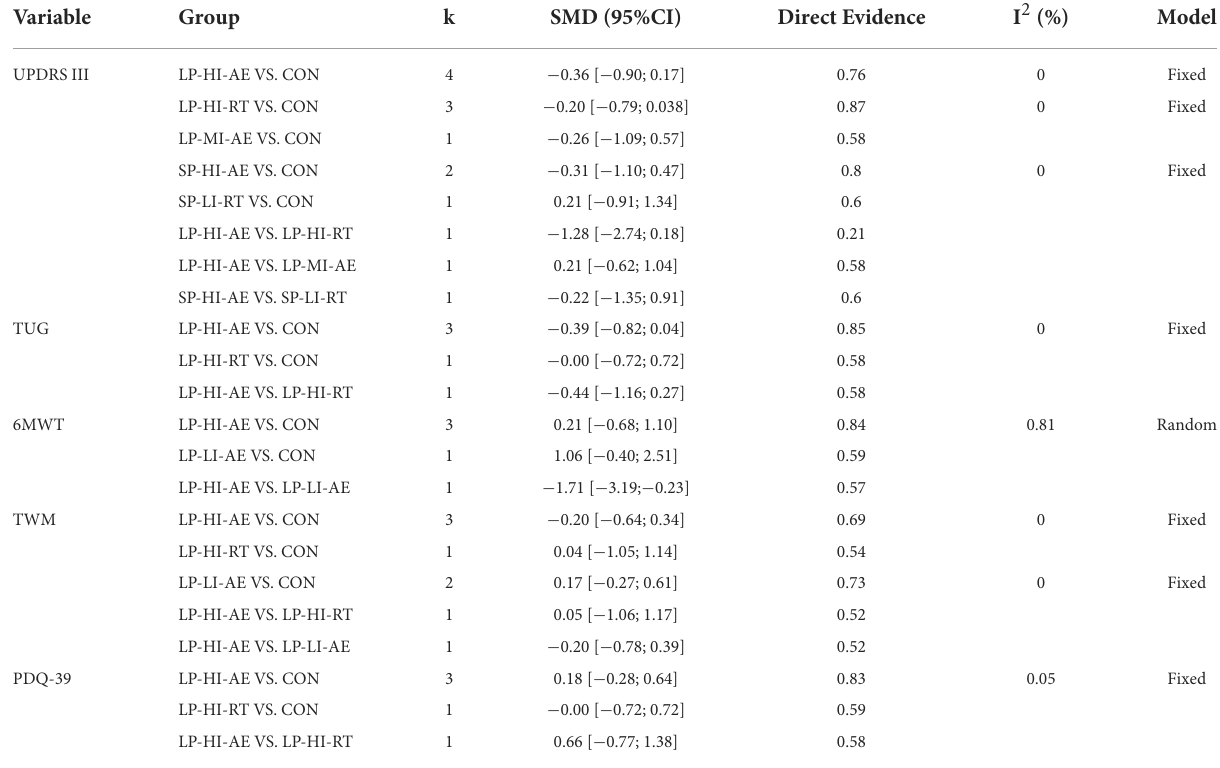
TABLE 4 Results of Direct meta-analysis.